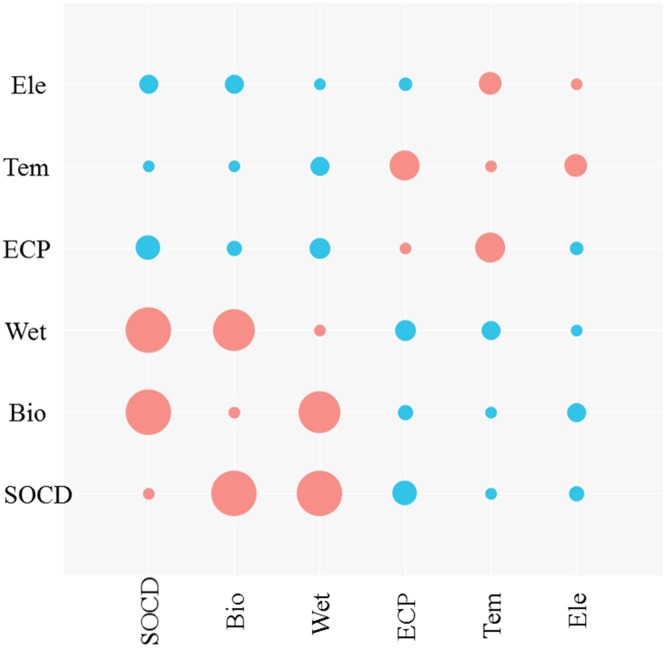
Correlation matrix of SOCD and influential factors for grasslands on the QTP.